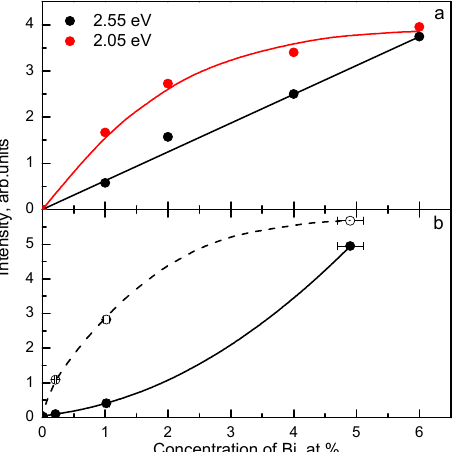
Figure 16. ( a ) The excitation band of the Bi 3+ -related 2.19 eV emission measured at the same conditions at 295 K for the YVO 4 :Bi powders with different Bi 3+ contents (shown in the legend). ( b ) The dependences of the 2.19 eV emission intensity, taken from Figure 16a for some selected excitation energies, on the Bi 3+ content. See also [76]. Presented with the publisher’s permission.